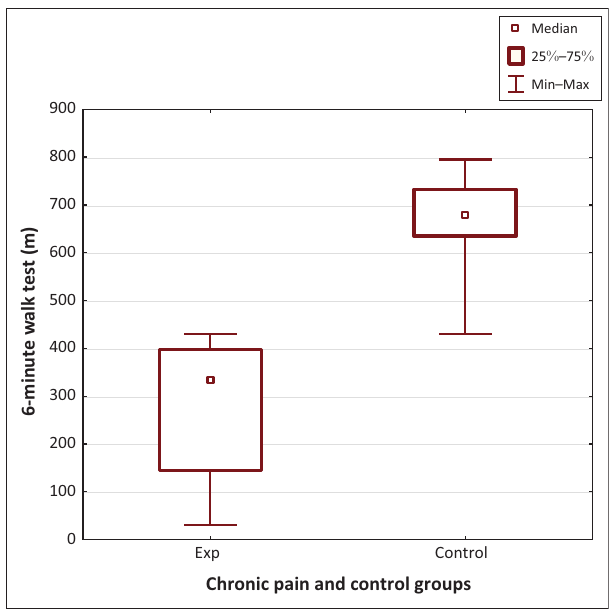
FIGURE 2: Distance walked in 6-minute walk test for the Chronic Pain and Control Groups.